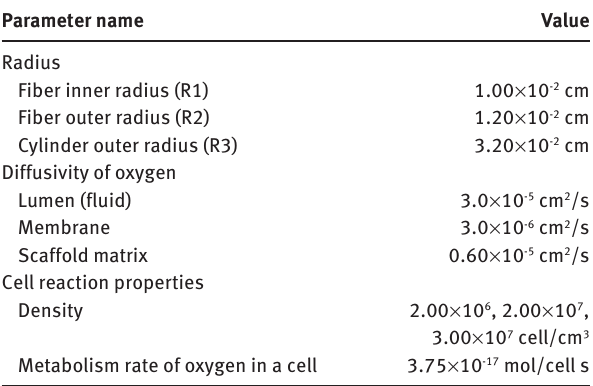
Table 2 Material properties for convective bioreactor analysis